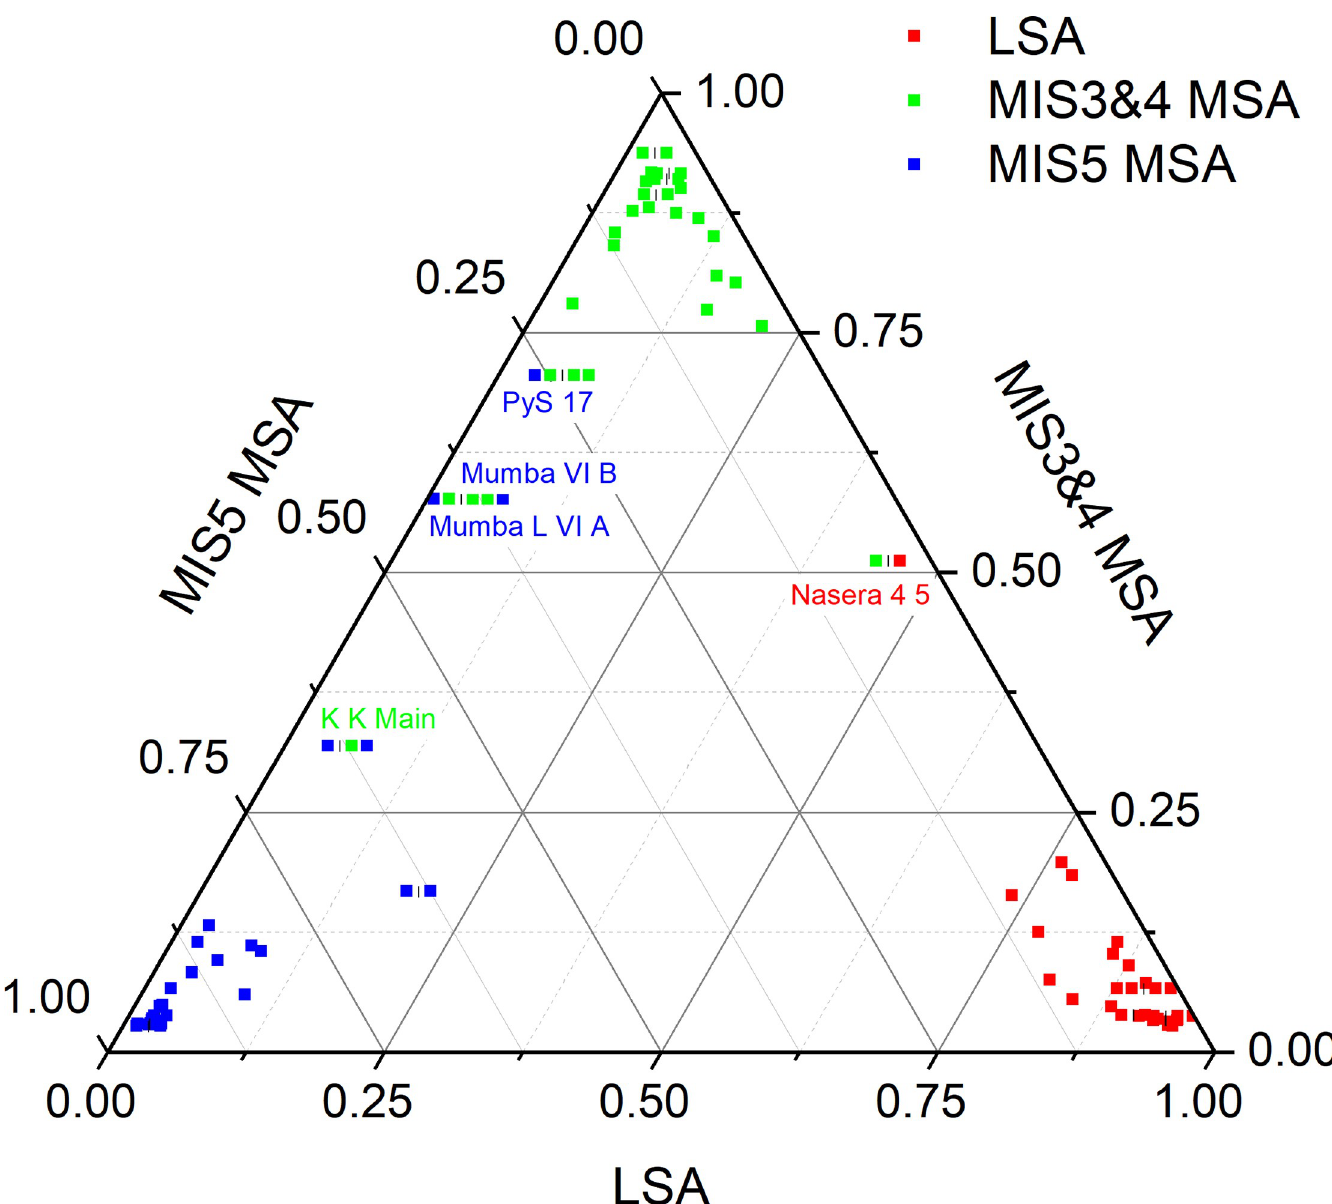
Fig 5. Ternary plot of exact classification probabilities (3-way). Exact classification probabilities for the 92 assemblages in the 3-way analysis via the weighted mean of the ensemble of 1,000 networks. The location of a point shows simultaneously the probabilities of it being classified as LSA, MIS3&4 MSA, and MIS5 MSA. Correctly classified assemblages will be at or close to the maximum for their respective axis. Incorrectly classified assemblages are labelled. Where multiple assemblages plot in the same location they are re-arranged horizontally around the bar (|) symbol that shows their true location. https://doi.org/10.1371/journal.pone.0237528.g005 Table 8 (as this is a 2-way analysis, the equivalent MSA results are the inverse of Table 8, and are not shown). Overall, 7 technologies were significant indicators or contra-indicators of